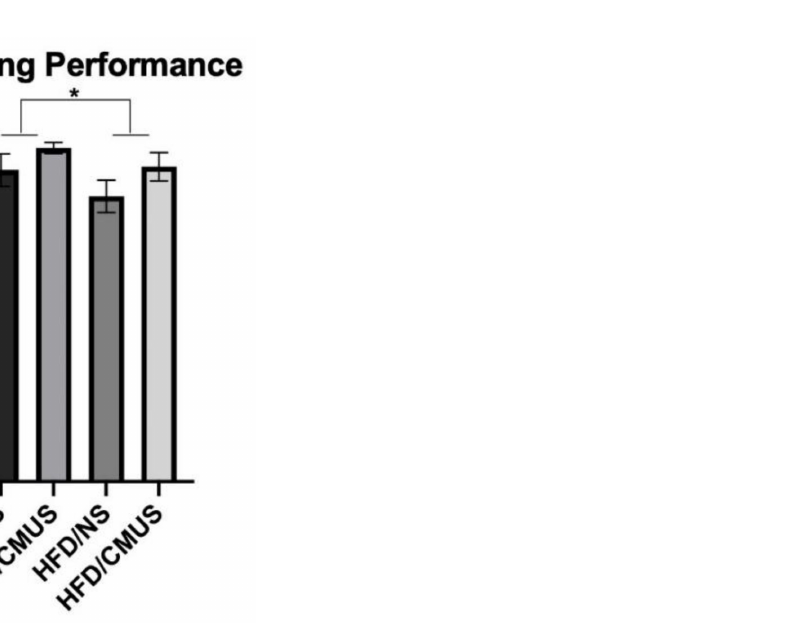
Figure 11. Nesting behavior. Nest construction was significantly altered by HFD administration. Mice given a HFD had significantly lower nest scores as compared to control mice. (* p <